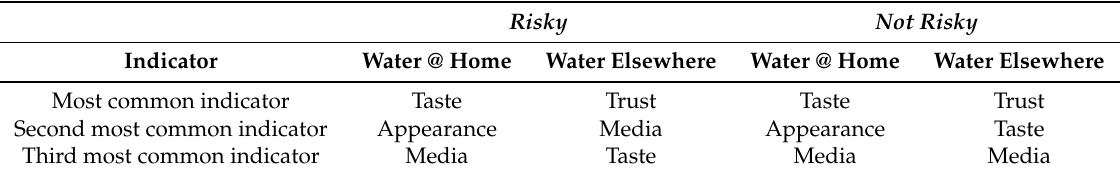
Table 2. Type and frequency of indicators used to assess drinking water quality at and away from home.